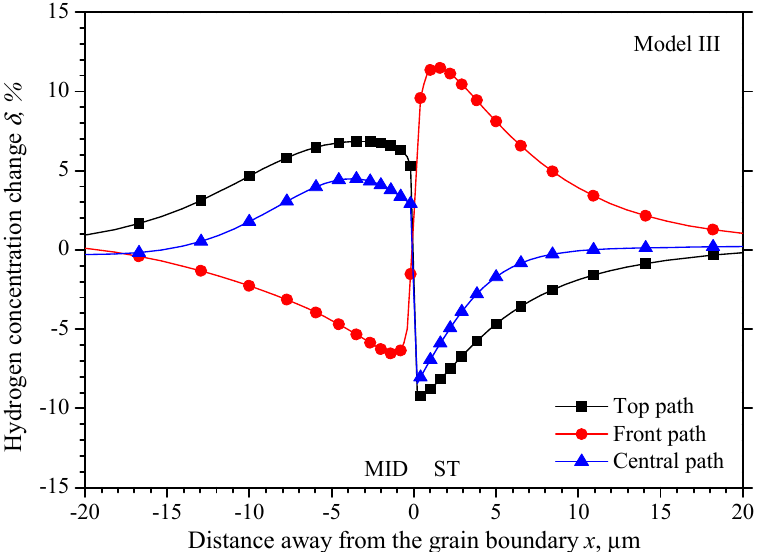
Figure 11. The hydrogen concentration distribution in model III bicrystal.